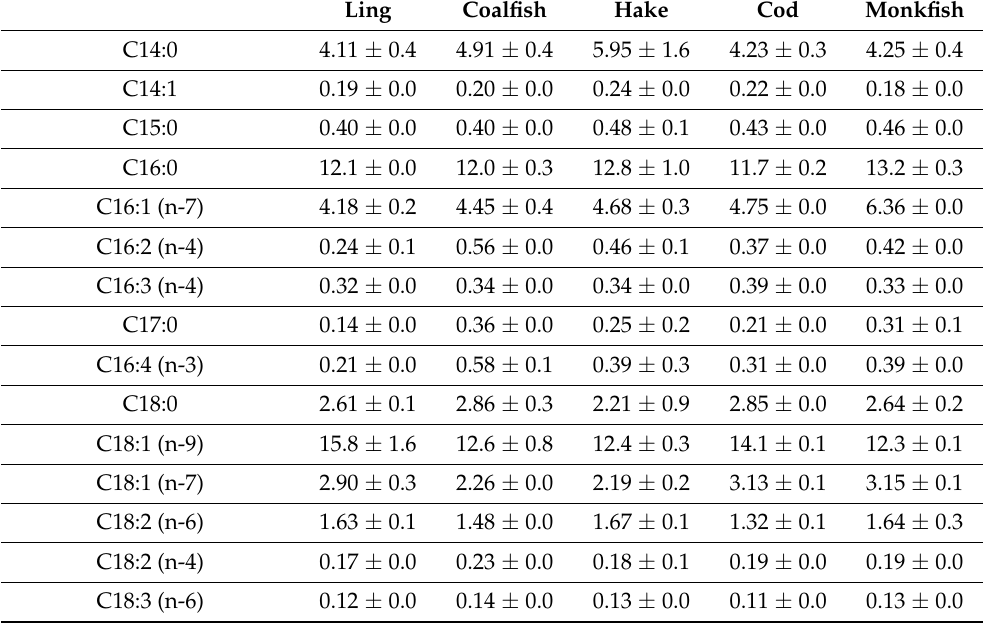
Table 3. Fatty acids (% of total fatty acids) measured in the extracted oil from livers of different fish species sampled in November 2016. Only fatty acids present in concentrations >0.1% are shown. Ling Coalfish Hake Cod